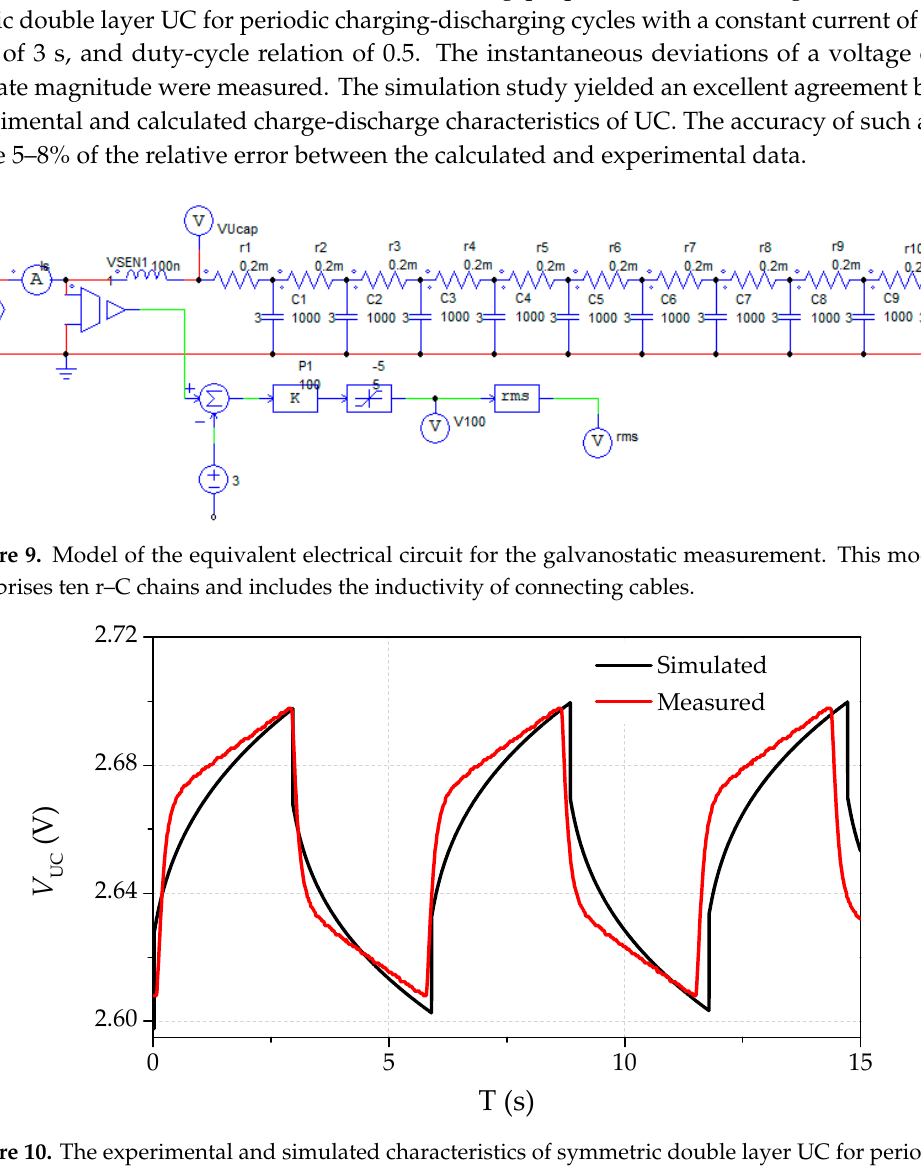
Figure 10. The experimental and simulated characteristics of symmetric double layer UC for periodic charging and discharging cycles.